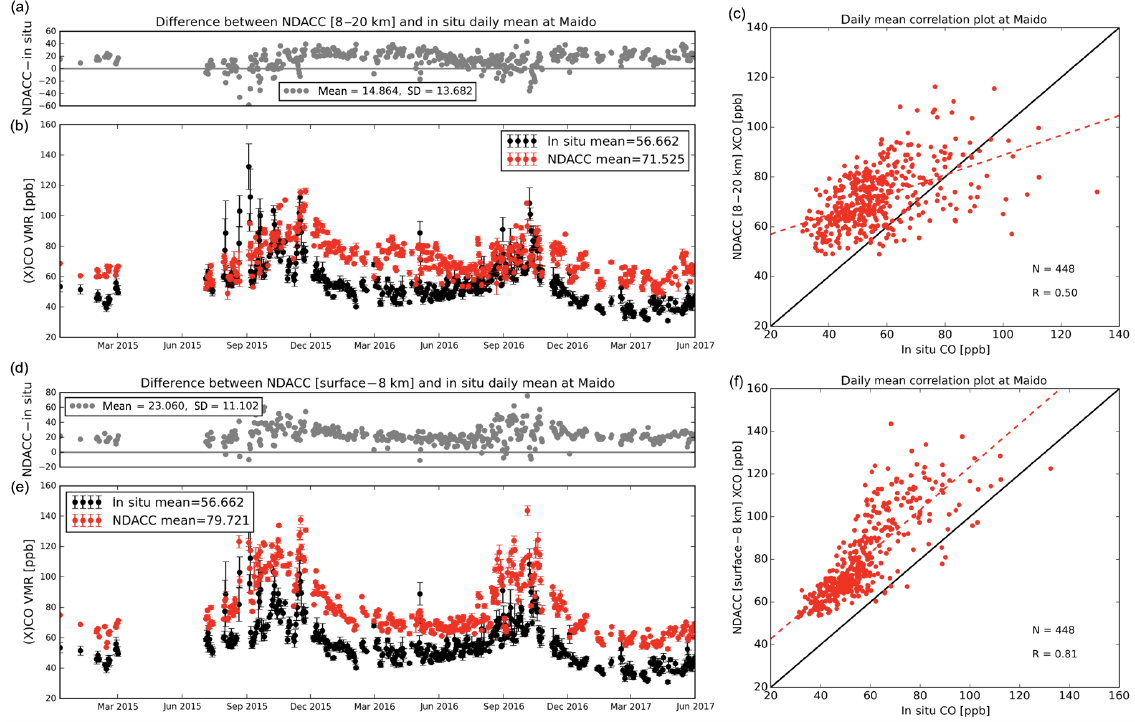
Figure 9. The time series of the daily means and standard deviations from the daytime in situ CO measurements and NDACC X CO in vertical ranges from 8 to 20km (b) and the surface to 8km (e) at Maïdo, in addition to the absolute difference (unit: ppb) between them (a, d) and their correlation (c, f)